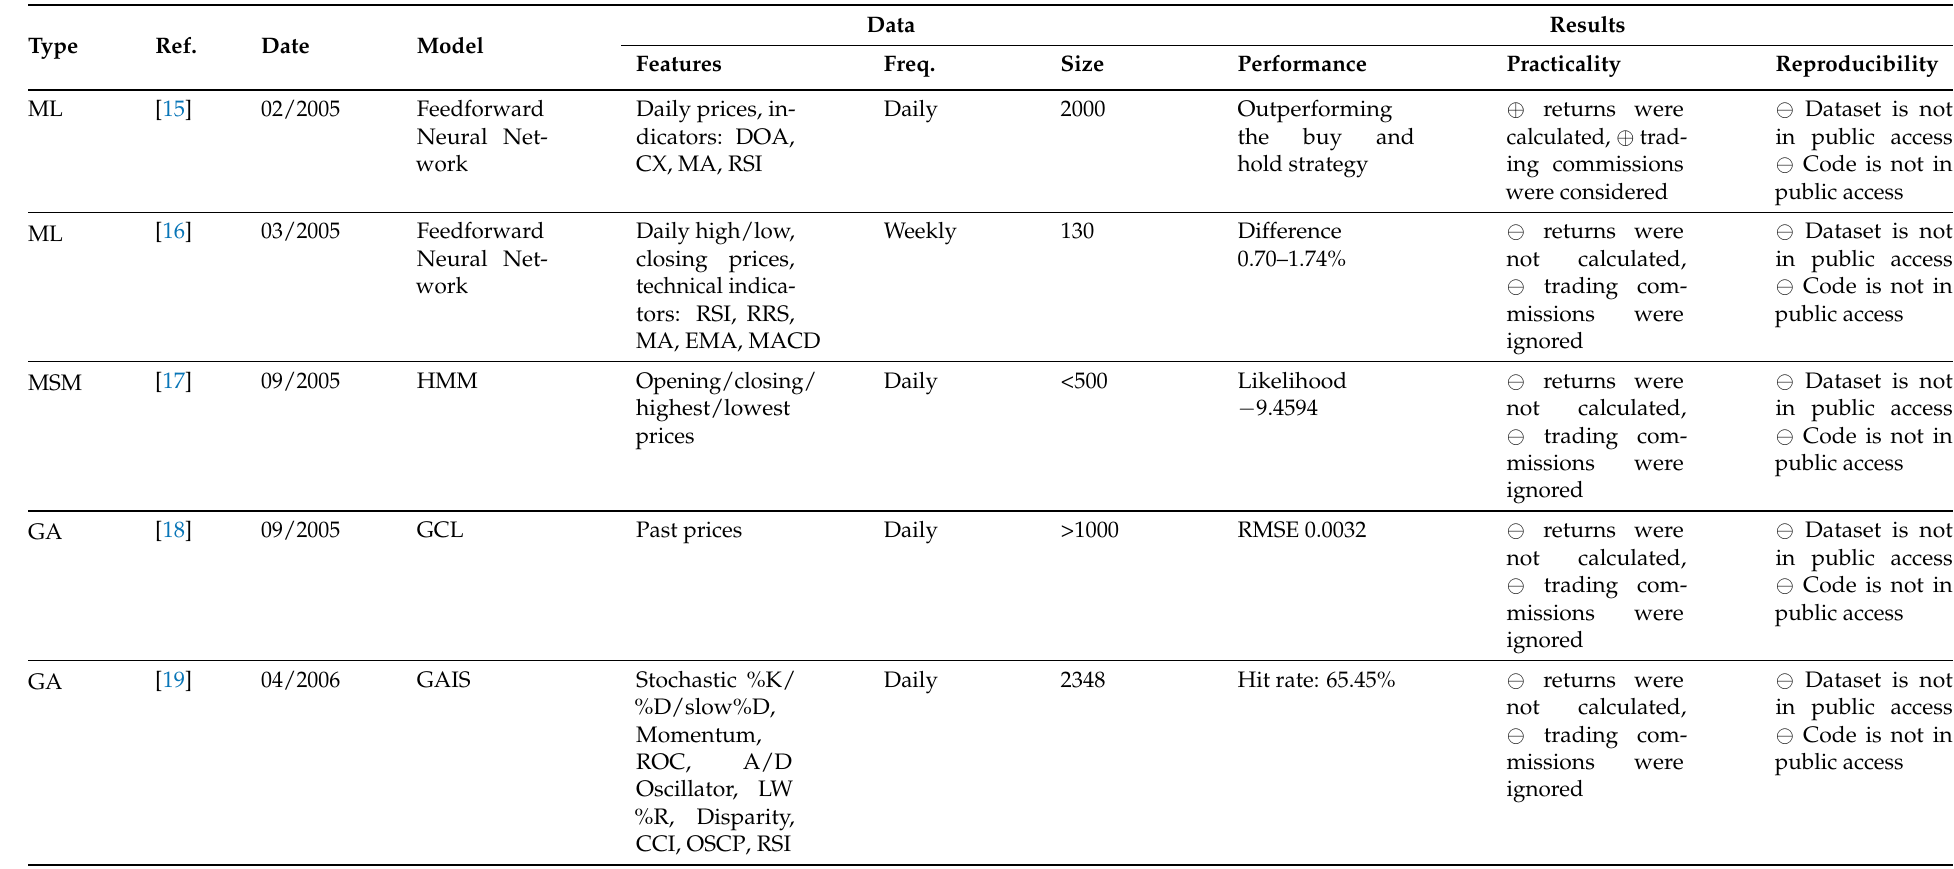
Table 2. State-of-the-art stock price prediction models based on market